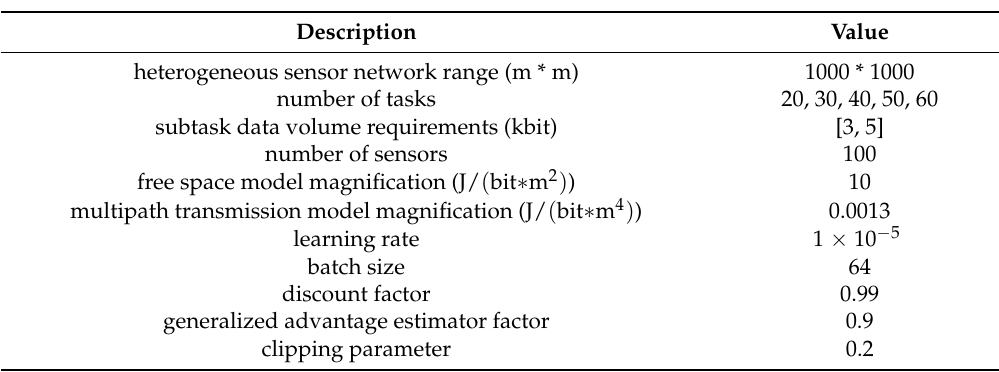
Table 1. Parameters of the sensor networks and